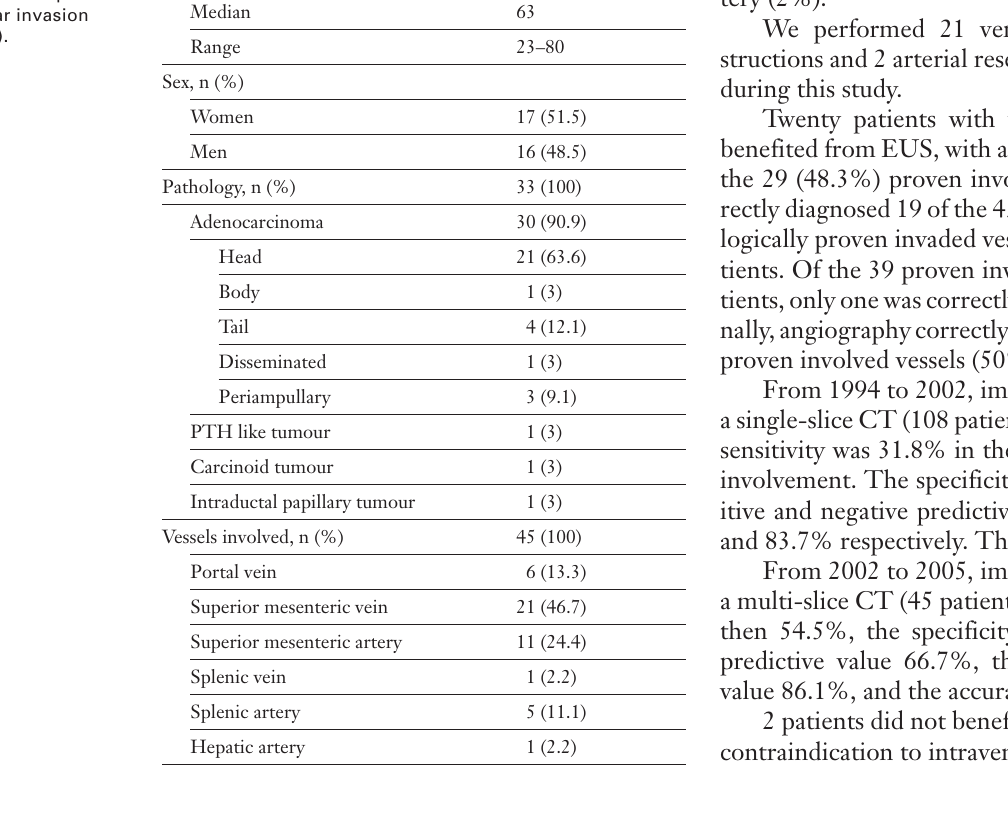
Table 2 Characteristics in patients with proven vascular invasion (n = 33).